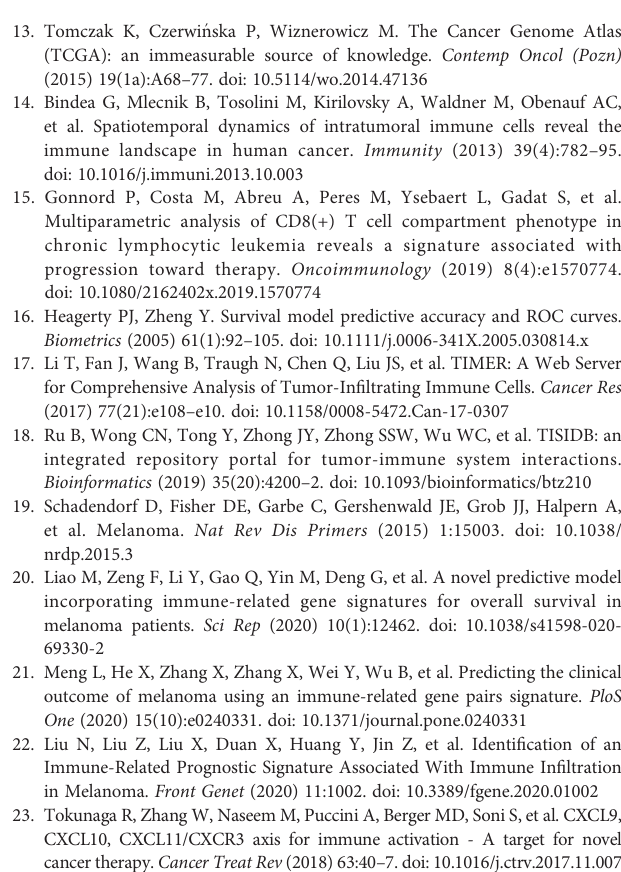
SUPPLEMENTARY FIGURE 1 | The expression of CXCL11and LTF in melanoma patients from the GEO cohort (GSE15605), P < 0.001. SUPPLEMENTARY FIGURE 2 | The expression of CXCL11, LTF, and HLA- DQB1 in the group of cutaneous melanoma and normal control. SUPPLEMENTARY FIGURE 3 | Analysis of the expression of IGHV1-18, CXCL11, LTF, and HLA-DQB1 in different molecular subtypes of cutaneous